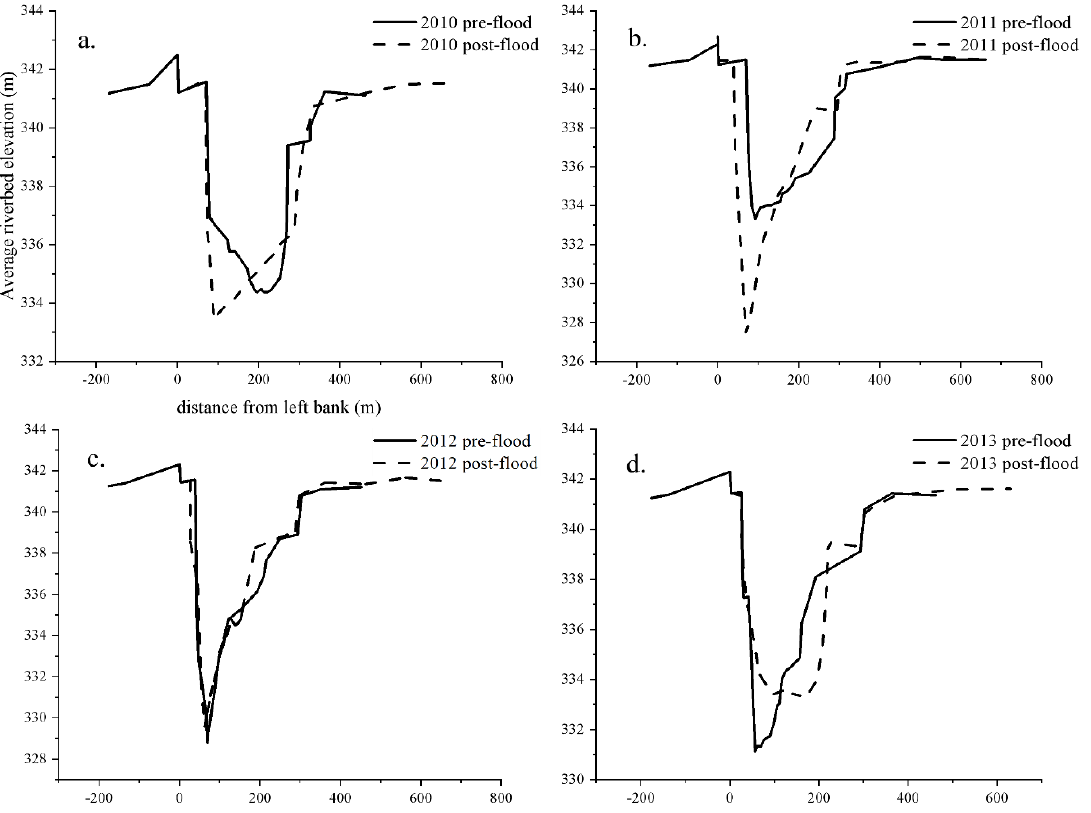
Figure 12. Comparison of the cross-section before and after the flood season in: ( a ) 2010; ( b ) 2011; and ( c ) 2012 (d) 2013 at Huaxian Station.